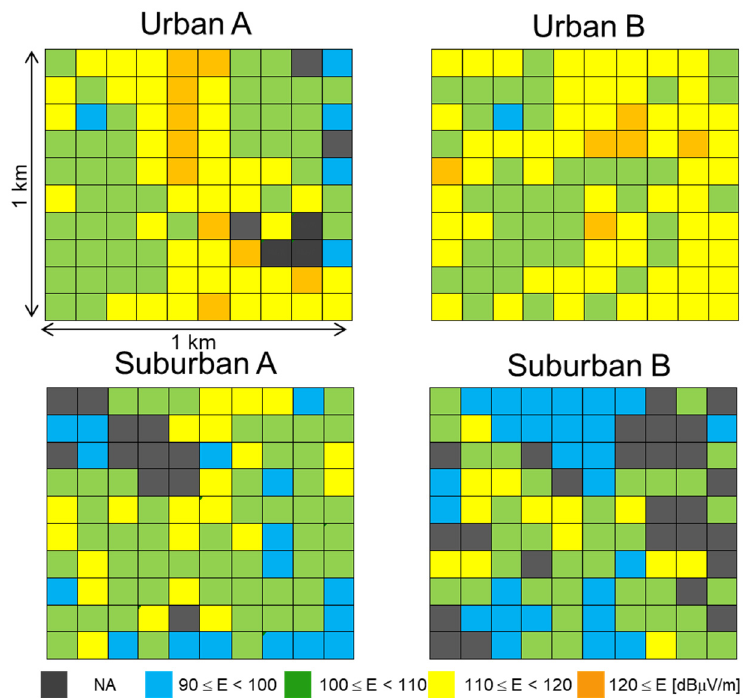
Figure 1. E-field strength in all frequency bands in the outdoor environments.